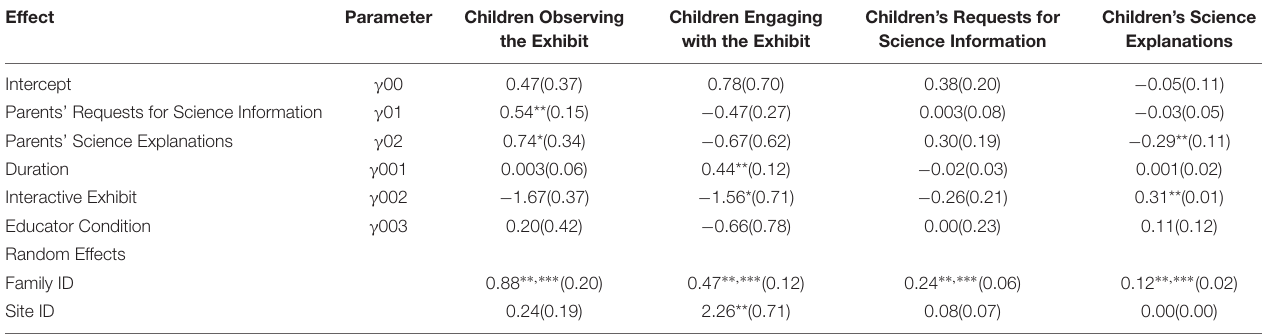
TABLE 6 | Unstandardized coefficients (and standard errors) of multilevel models of children’s behaviors.